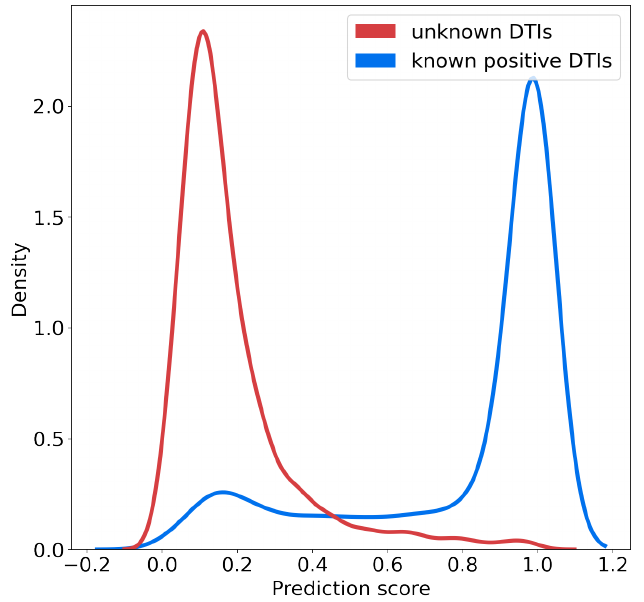
Figure 4. Distribution of the probability scores predicted for known positive DTIs and randomly chosen negative DTIs among unlabeled DTIs.